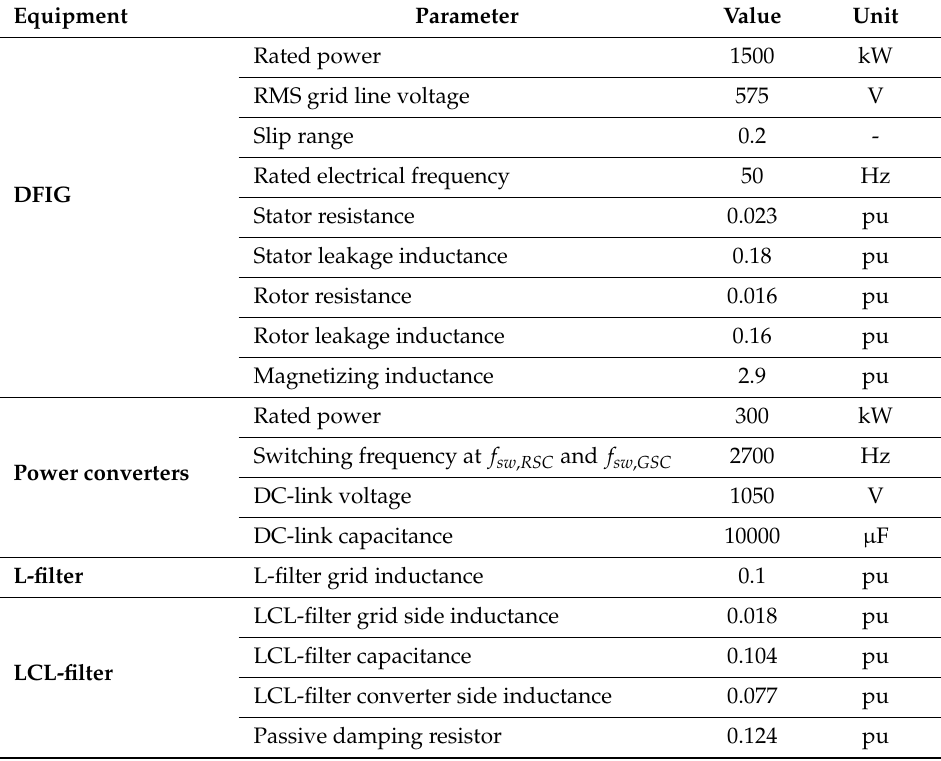
Table 1. Parameters for a 1.5 MW DFIG systems.